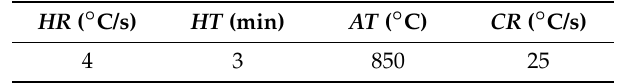
Table 2. Dilatometry parameters for the steels. HR = heating rate, HT = time at annealing temperature, AT = annealing temperature and CR = cooling